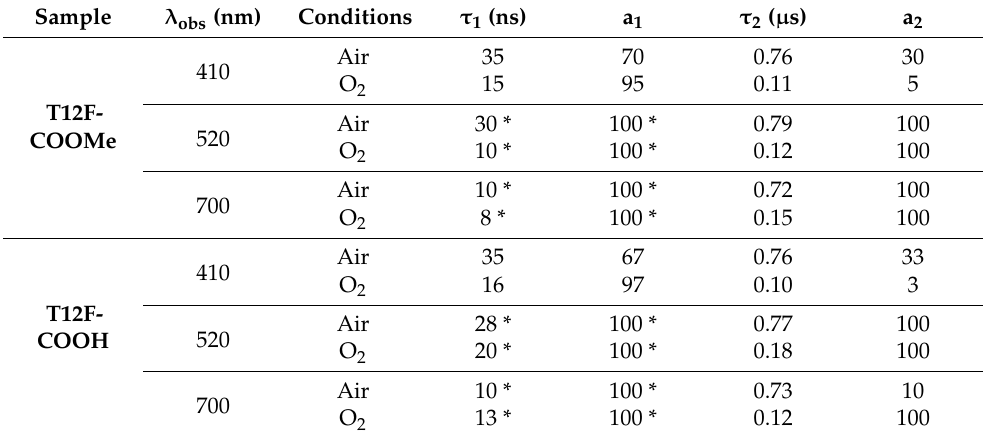
Figure 4. Time-resolved transient absorption spectra at different delay times (ns– µ s) upon excitation at 355 nm of ( A ) T12F-COOMe and ( B ) T12F-COOH in DMF solution. Transient decays ( µ s regime) under atmospheric conditions (air) at the indicated probing wavelengths of ( C ) T12F-COOMe and ( D ) T12F-COOH in DMF solution. The solid lines are from the best fit using a multiexponential function. Table 3. Values of time constants ( τ i ) and normalized (to 100) pre-exponential factors (a i ) obtained from the best fits of the transient absorption decays of T12F-COOMe and T12F-COOH in DMF solution upon excitation at 355 nm, and probing wavelengths as indicated. * The signal is negative in sign, reflecting an emissive process. The errors in the time constant values are about 15%. Sample λ obs